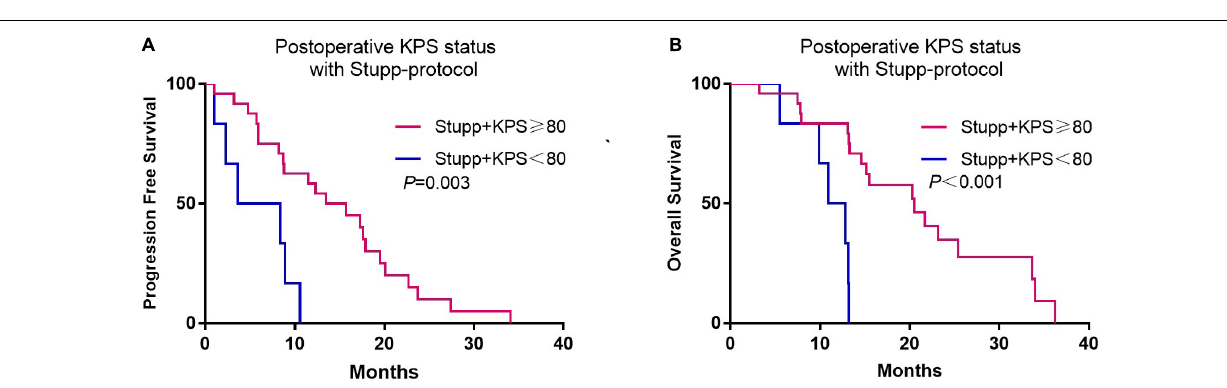
non-significant influence on PFS ( p = 0.051) and OS ( p